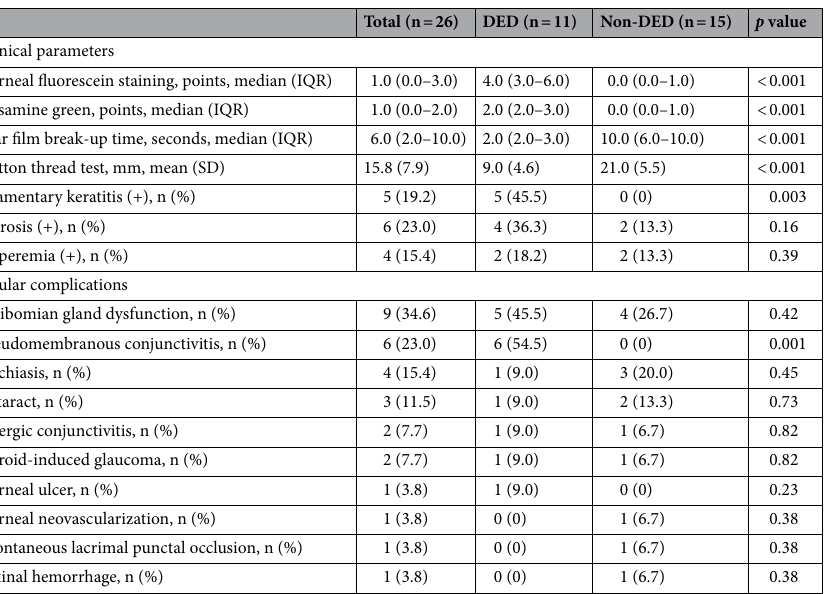
Table 2. The association of clinical findings in patients with DED and patients without DED. DED dry eye disease; IQR interquartile range; SD standard deviation; ( +) positive.